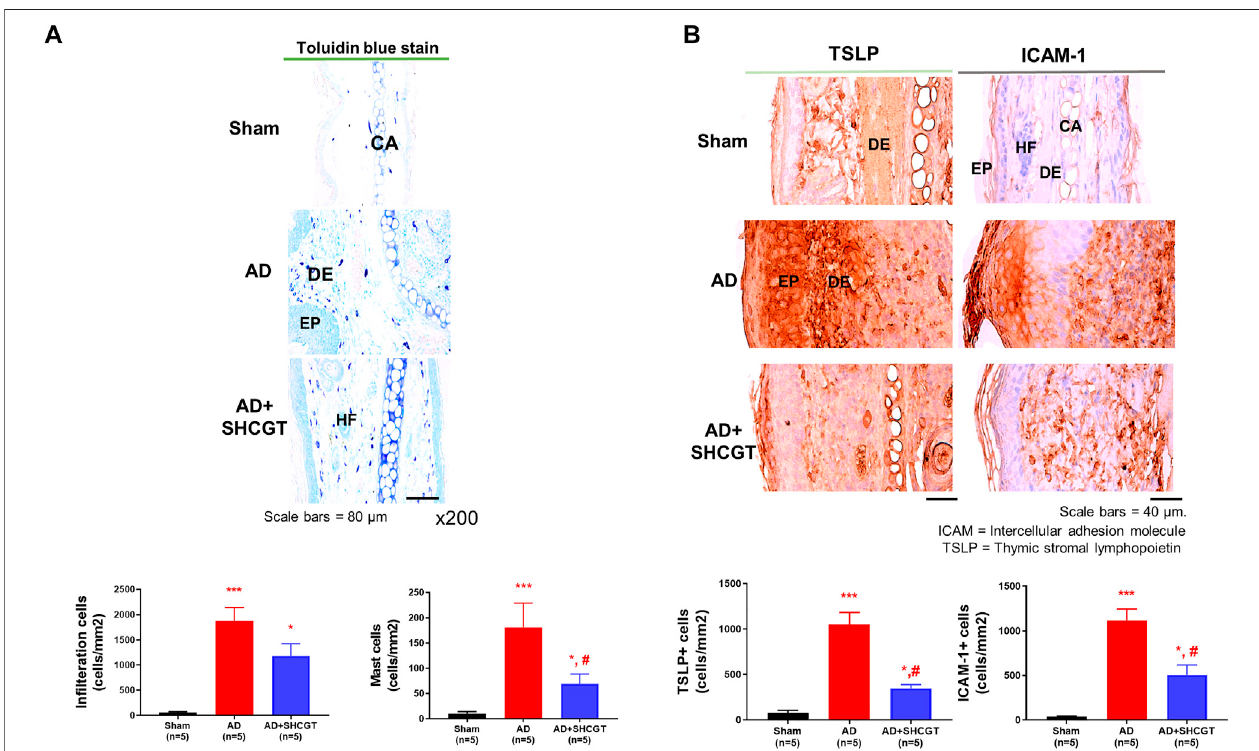
FIGURE 3 | SHCGT inhibited the in fi ltration of in fl ammatory cells and the expression of TSLP and ICAM-1 in mice with DNCB-induced AD. (A) Toluidine blue- stained mast cells in ear skin tissue. SHCGT reduced the in fi ltration of in fl ammatory cells, including mast cells, in the ear skin of mice with DNCB-induced AD. (B) Immunohistochemistry staining for TSLP and ICAM-1 in ear skin. SHCGT signi fi cantly decreased the expression of TSLP and ICAM-1 in mice with DNCB-induced AD. * p < 0.05, *** p < 0.001 vs. sham; # p < 0.05 vs. AD. AD, atopic dermatitis; DNBC, 2,4-dinitrochlorobenzene; ICAM-1, intercellular adhesion molecule-1;